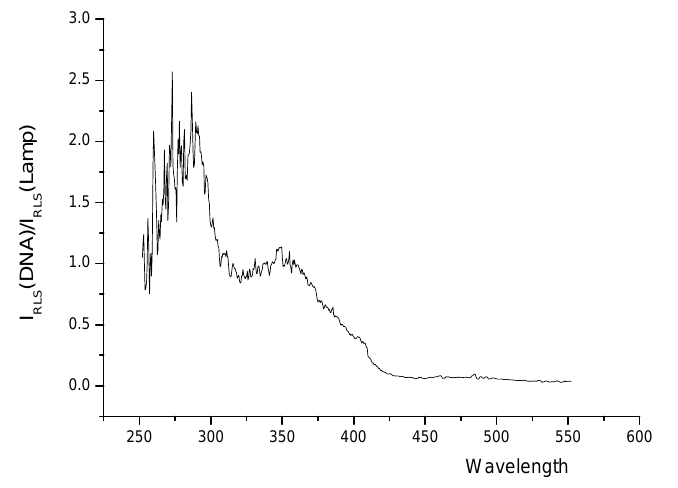
Figure 5. The corrected RLS profiles of Eu 3+ -nicotinic acid-fsDNA system.